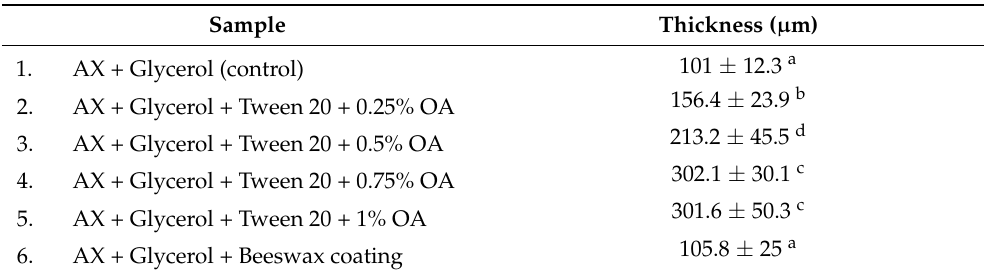
Table 4. Thicknesses of all the film samples. Values in the same column followed by different superscript letters differ significantly ( p <